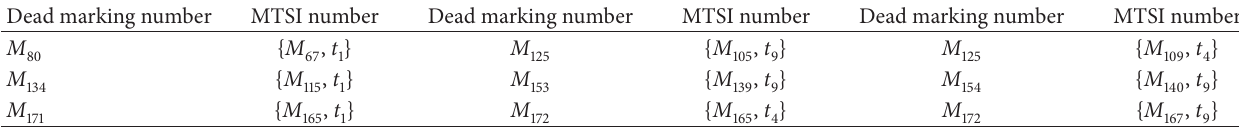
Table 5: The information of type I CMTSIs.